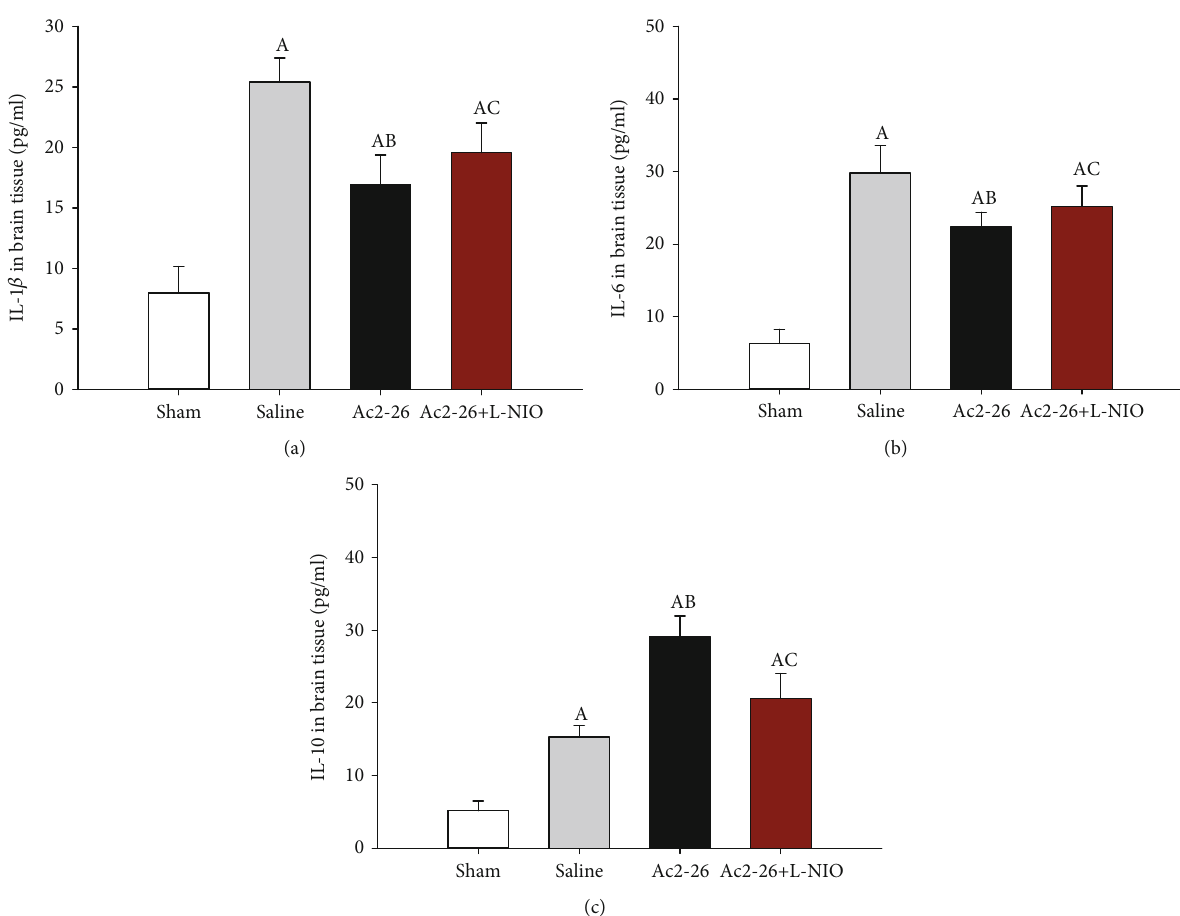
Figure 5: Cytokine (IL-1 β , IL-6, and IL-10) expression in the brain tissues after ROSC. Cytokine (IL-1 β , IL-6, and IL-10) expression in the brain tissue was measured using ELISA 72 hours after ROSC. Data are presented as mean ± SD . A P < 0 : 05 vs. sham group; AB P < 0 : 05 vs. saline group; AC P < 0 : 05 vs. Ac2-26 group (, sham group; , saline group; , Ac2-26 group; , Ac2-26+L-NIO